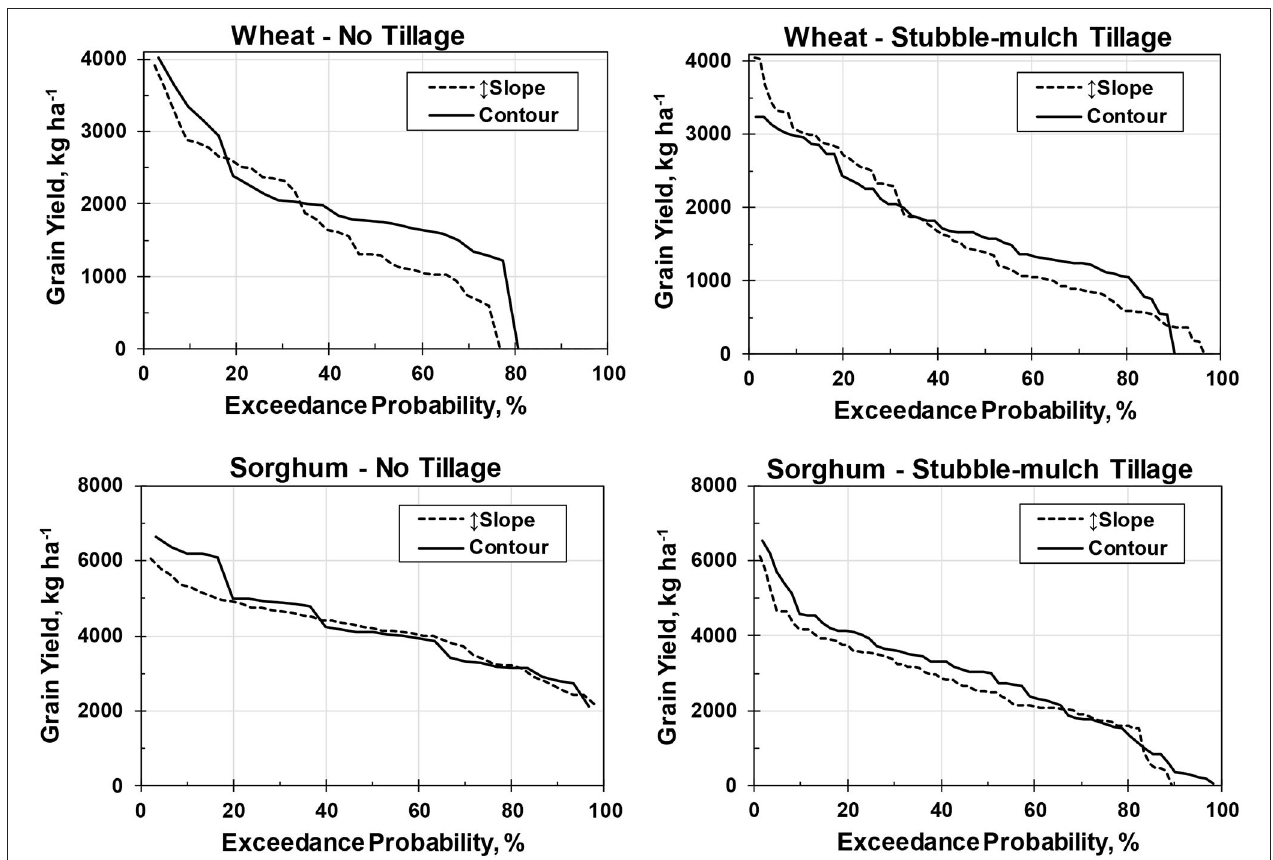
FIGURE 2 | The with-slope ( l Slope) or contour farming grain yield, kg ha − 1 , of wheat and sorghum for no and stubble-mulch tillage plotted as a function of exceedance